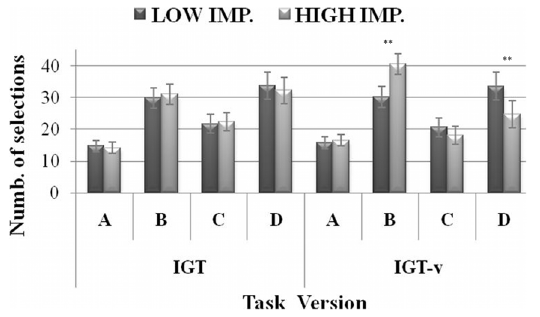
Figure 3. Selection from each deck as a function of IGT version. Mean number of cards chosen from each deck in the original (IGT) and modified (IGT-v) task versions. Vertical bars denote + / 2 0.95 confidence intervals, (*) p =0.055,* p # 0.05, *** p # 0.001.